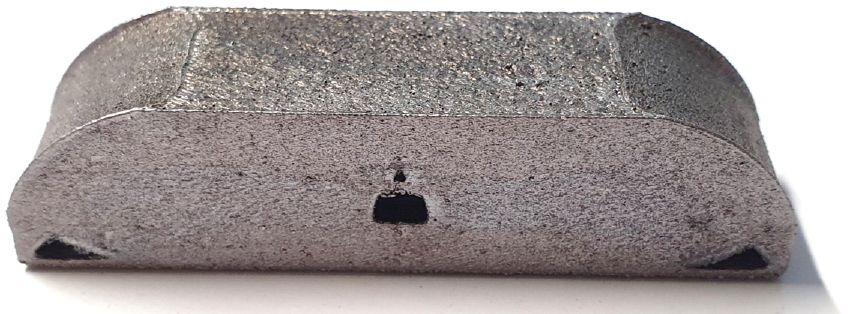
Figure 20. Design proposals of the developed topology optimization method for optimization case 1 manufactured in the PBF-LB